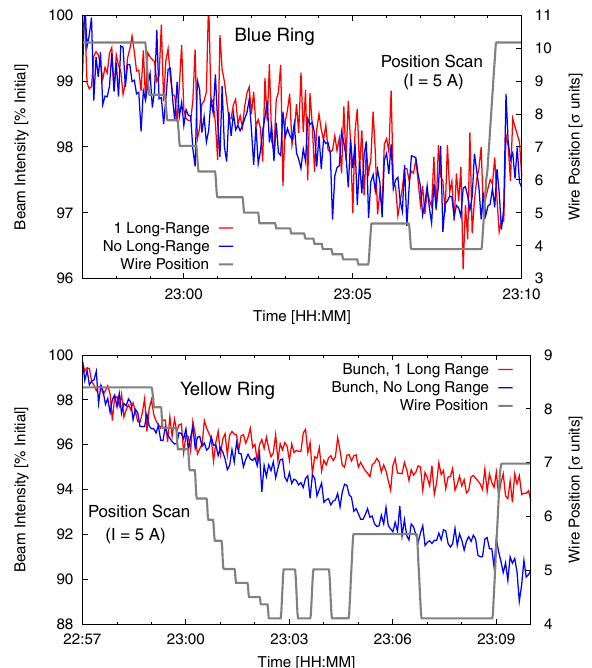
FIG. 20. Beam intensity comparison between bunches with a single long-range and no long-range interaction as a function of the wire position for Blue (top) and Yellow (bottom) rings with a wire current of 5